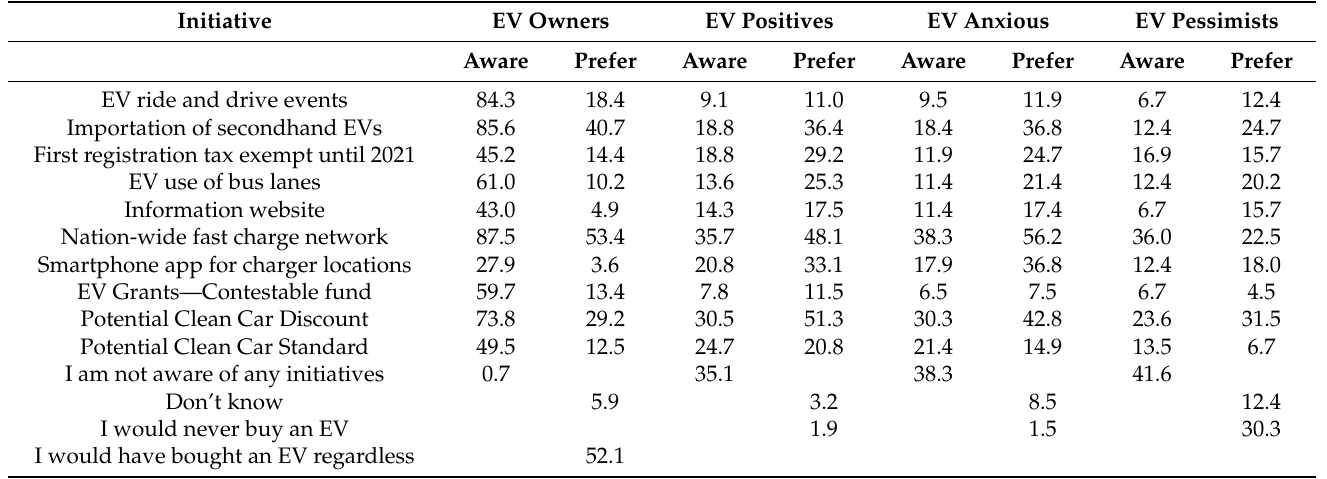
Figure 4. Box plot showing the number of initiatives motorists had heard of for each recorded ‘likelihood to purchase a BEV’ score. The dots on the figure represent outliers, the boxes represent the interquartile range for each score and the bold line represents the median score. The likelihood of purchasing a BEV increases as the number of initiatives a motorist is aware of increases. Table 4. NZ Government EV incentive policies: Awareness and preference of motorists, expressed as percentages for each Driver